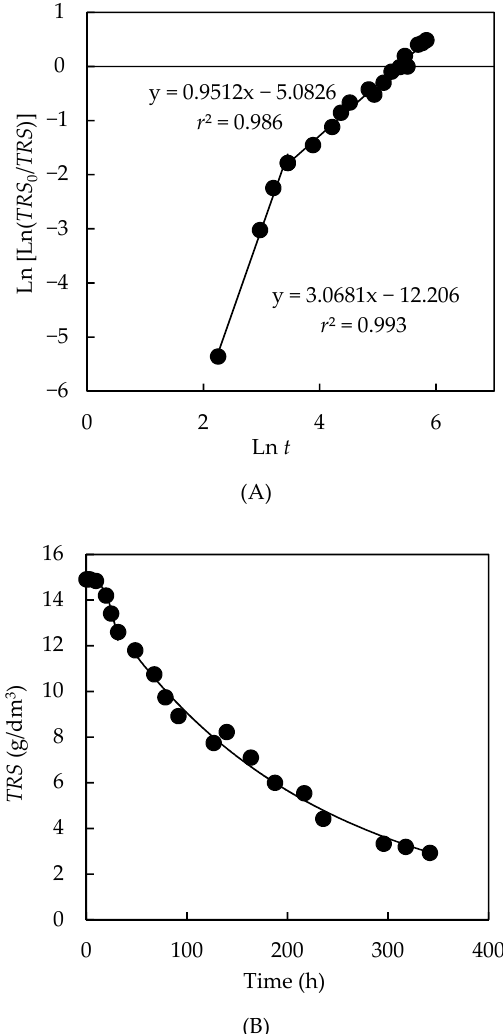
Figure 8. Total reducing sugar uptake over fermentation with P. tannophilus . ( A ) Fit of the experimental data to equation (5). ( B ) Comparison of the experimental concentrations (black points) with those predicted by model (line).